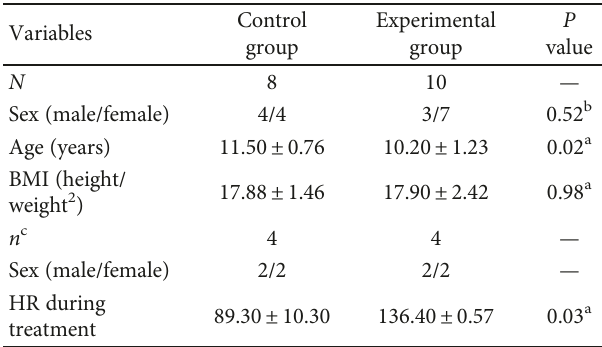
Table 1: Participants ’ demographics and treatment-induced heart rates ( M ± SD